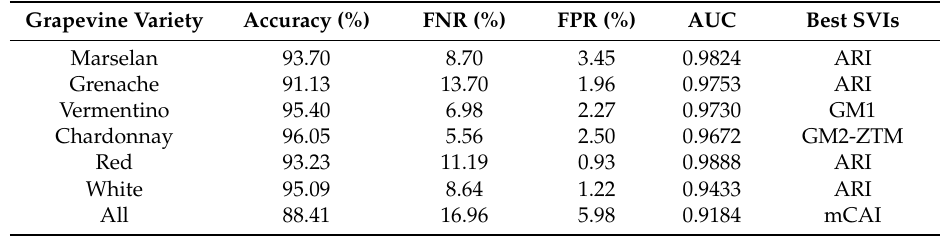
Table 8. Results of using the best SVIs in classifying different groups of spectral data acquired in the August and the September acquisition campaigns (Severity of infestation = 1 &